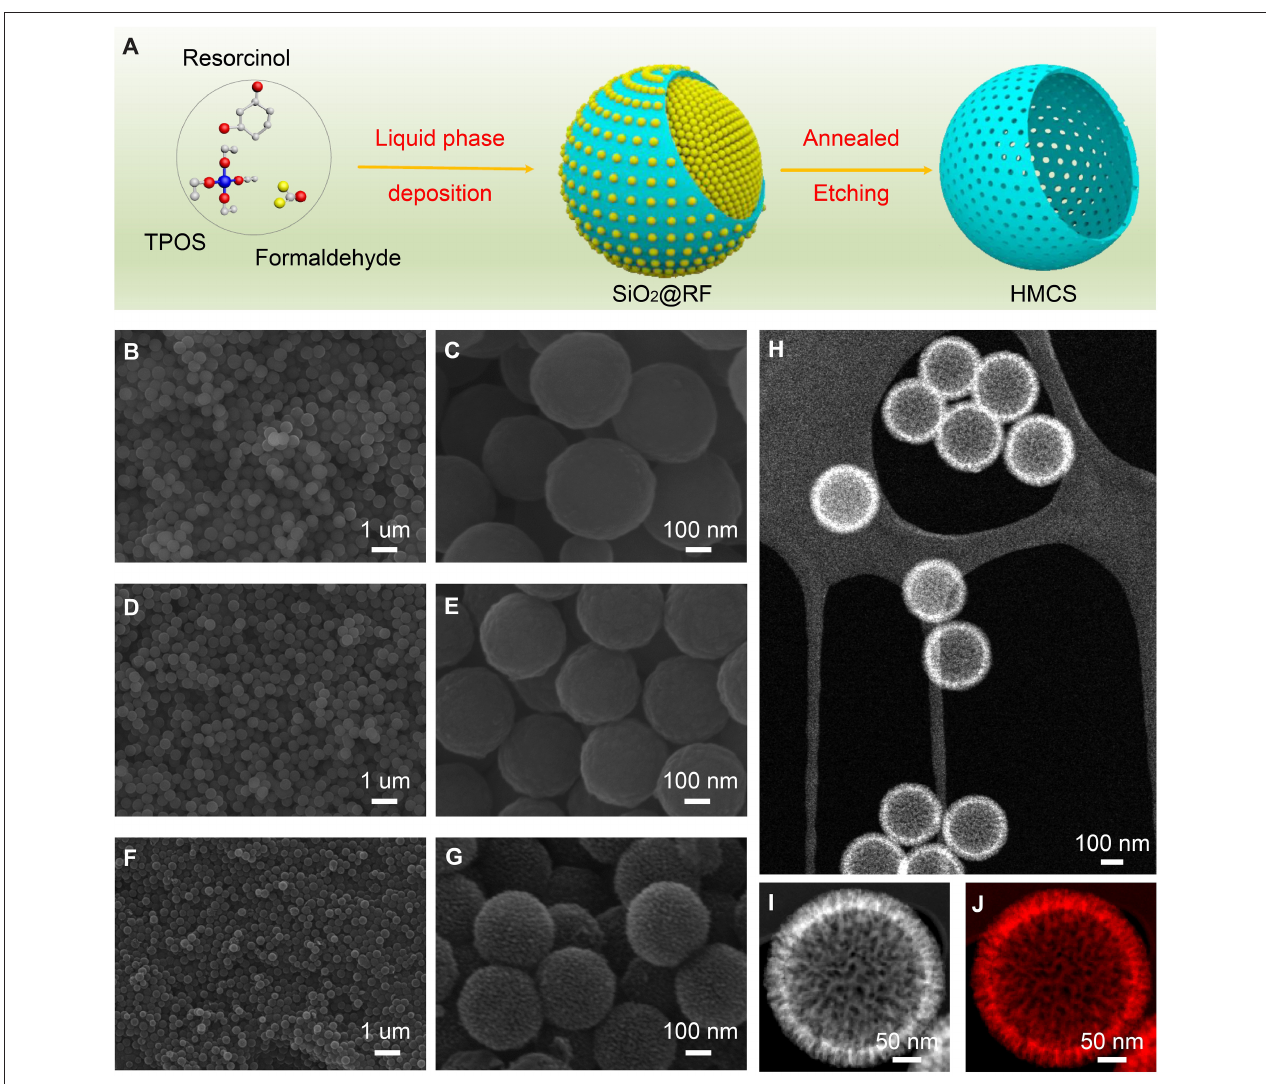
FIGURE 1 | (A) Illustration of the fabrication processes of hollow mesoporous carbon spheres. Low– and high–magnification SEM images (B,C) of resorcinol-formaldehyde-coated SiO 2 nanospheres intermediates, (D,E) carbon-coated SiO 2 intermediates after carbonizing the organic surface, and (F,G) carbon nanospheres, respectively. (H) HAADF image of as-synthesized carbon nanospheres, which shows obvious hollow spherical structures. (I) A magnified STEM image of one single carbon sphere with a porous surface and (J) C- K edge elemental